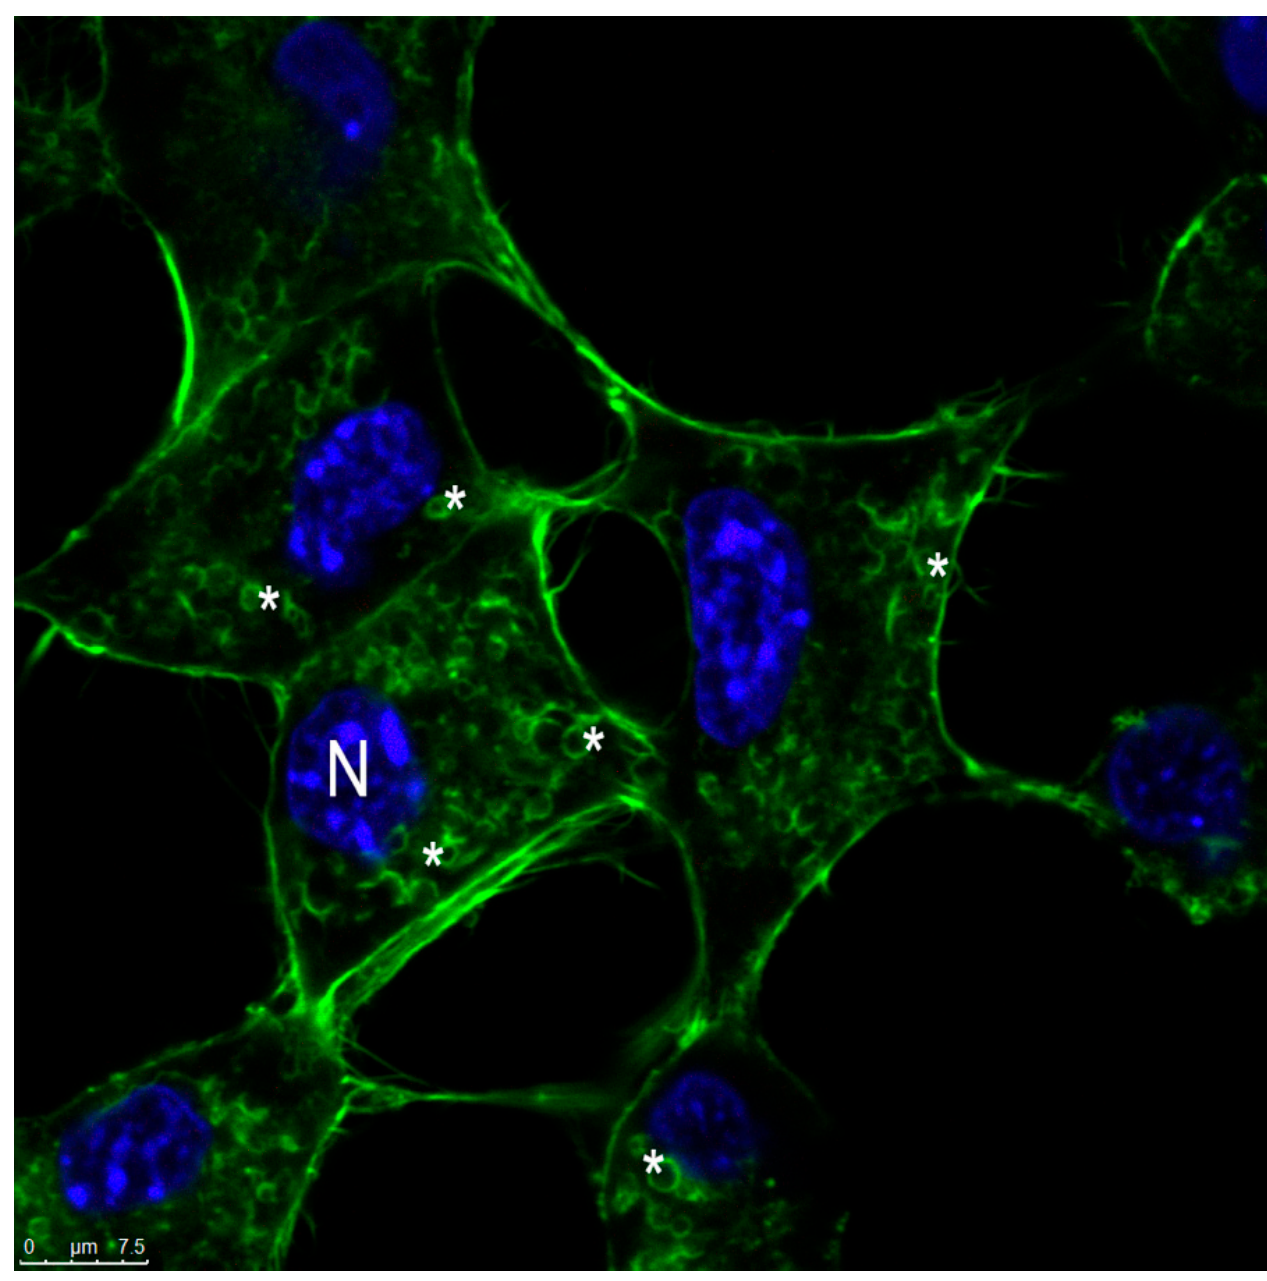
Figure 12. The cytoskeleton of B16-F10 cells. Macropynosomes (*) can be observed in B16-F10 cells treated with SLN-AlPc. In blue, the nucleus (N) can be observed.